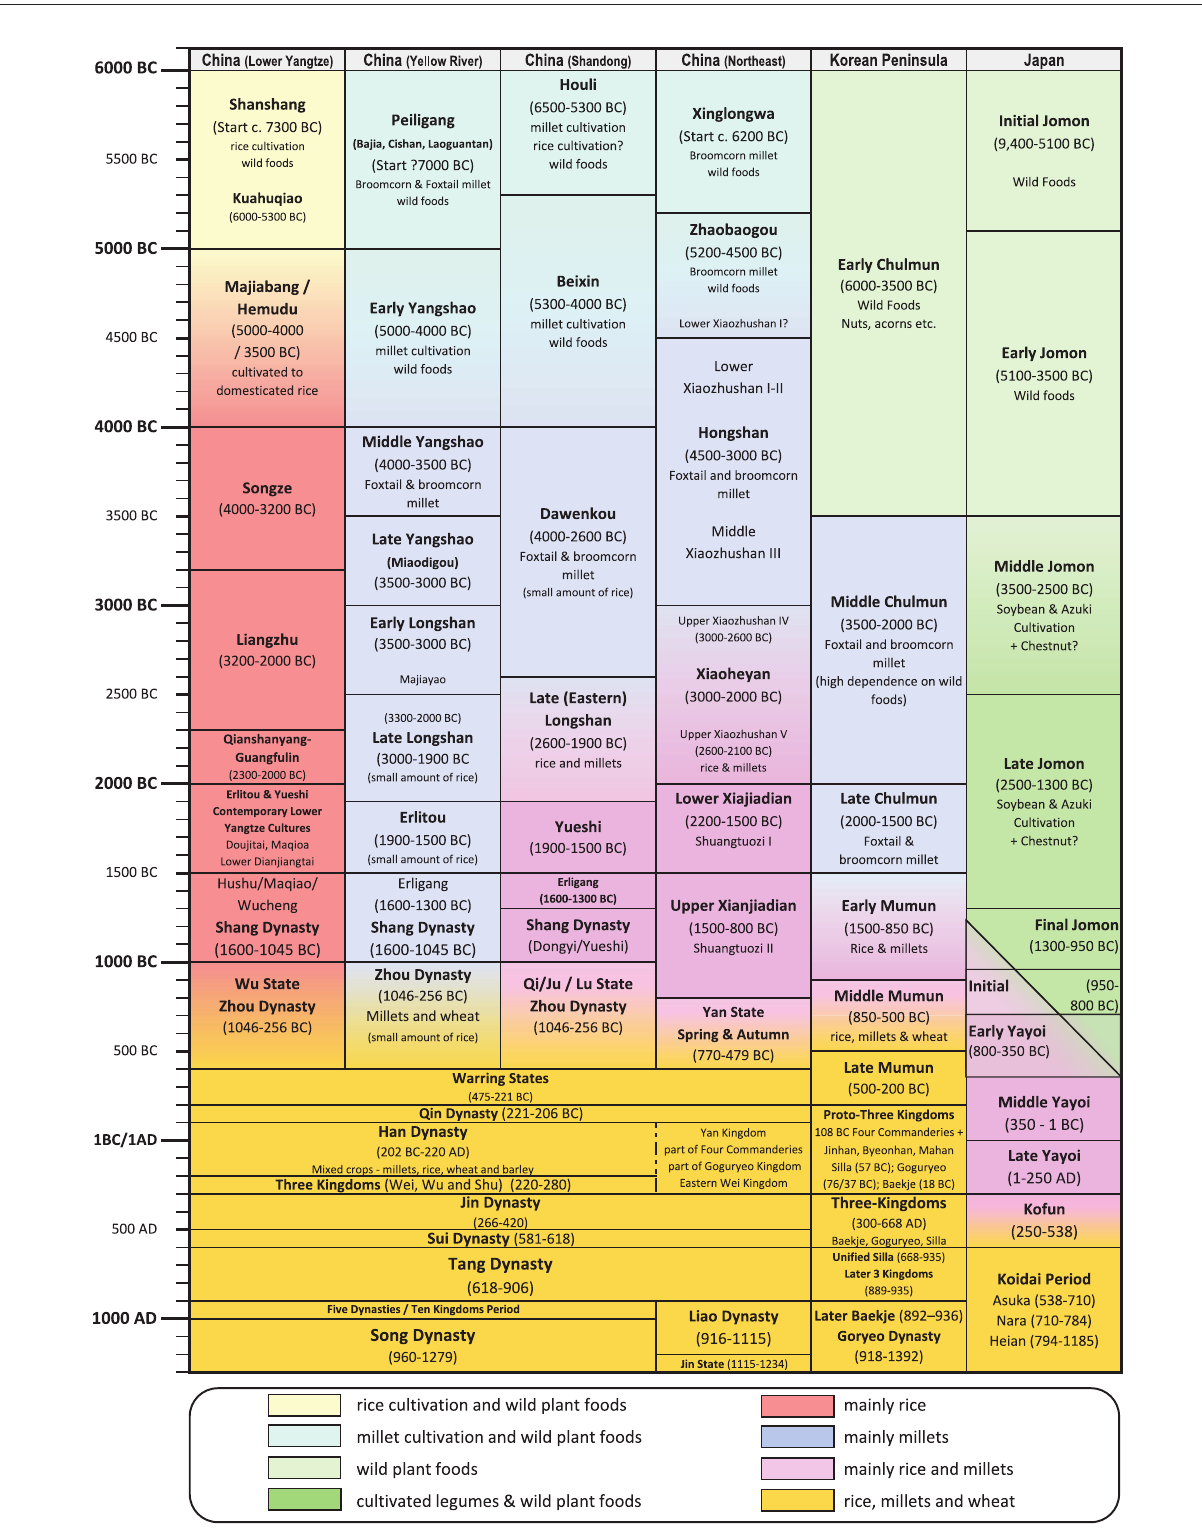
FIGURE1 Period divisions for Korea, Japan, and in China for Shandong, the Lower Yangtze, North East and Central China (cf. Liu and Chen, 2012; Barnes, 2015; Li et al., 2020). These divisions, especially for earlier periods are only approximate, and may vary geographically for any given region. This is particularly true of Japan where there is a west-east